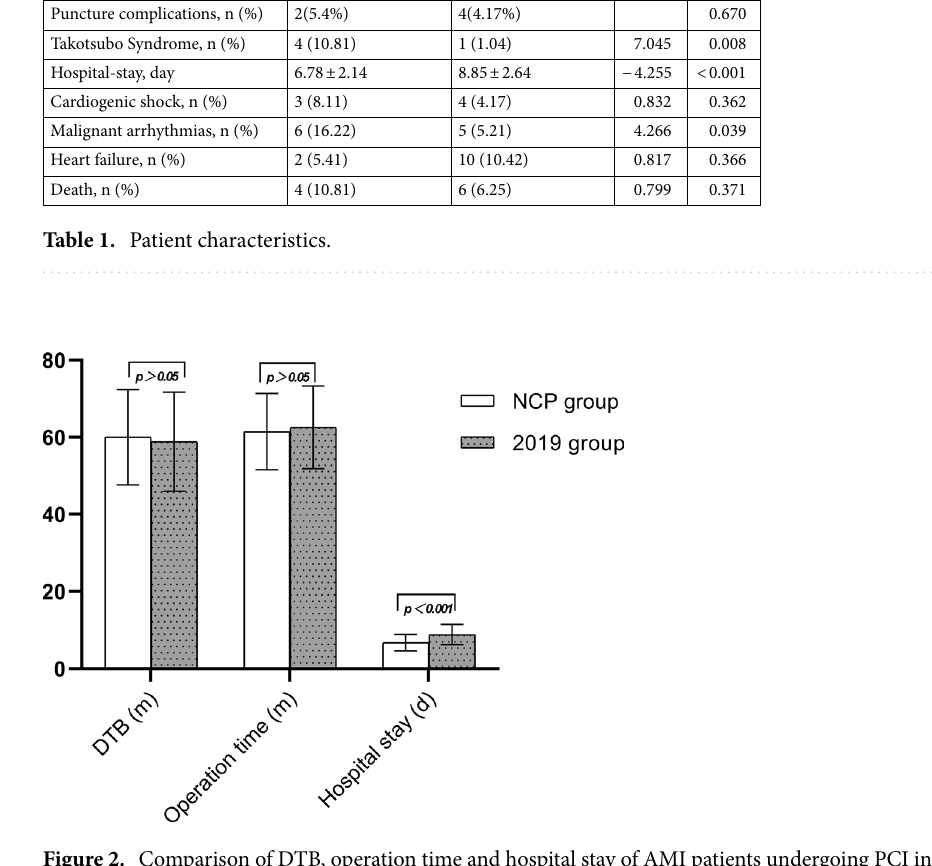
Figure 2. Comparison of DTB, operation time and hospital stay of AMI patients undergoing PCI in 2020 coronavirus disease (COVID-19) pandemic period and